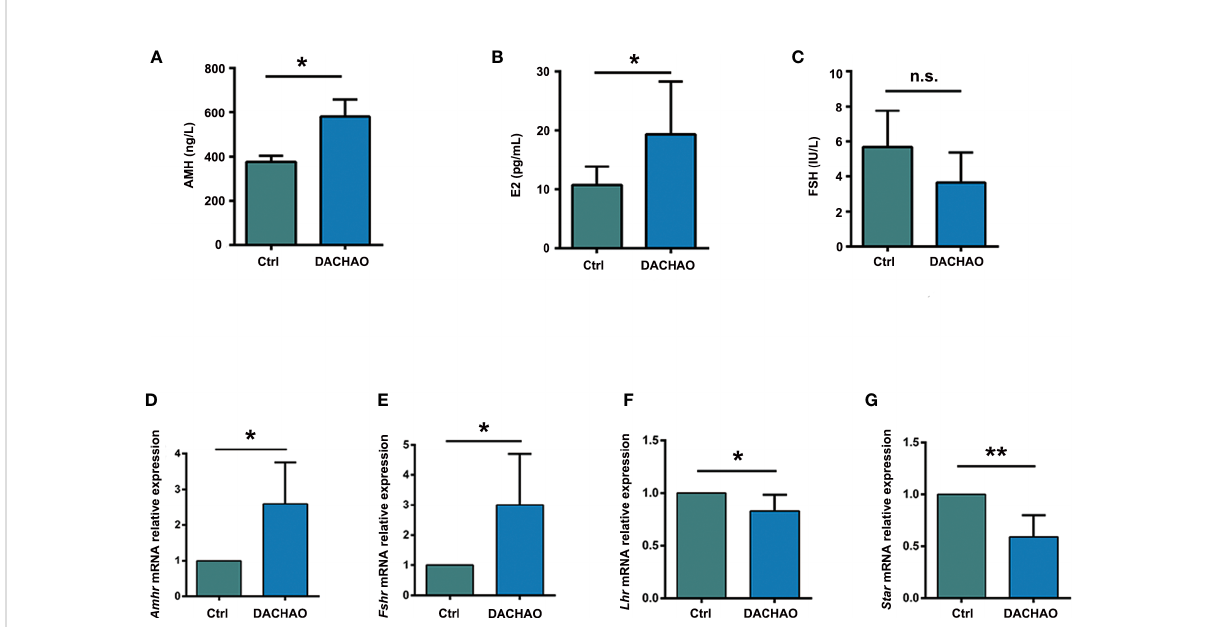
FIGURE 6 DACHAO enhanced the fertility by improving serum sex hormone levels and ovarian expression of hormone-related mRNAs. (A – C) Statistical analysis of serum AMH, E2, FSH values in aged female mice in each group (n=8/group). (D – G) Statistical analysis of relative expression of hormone-related mRNAs as Amhr, Fshr, Lhr and Star in ovaries of aged female mice in each group (n=3/group). Data are presented as means ± SEM of three independent replicates. *P < 0.05, **P < 0.01, and n.s. P ≥ 0.05, compared with the control group. n = the number of mice in each